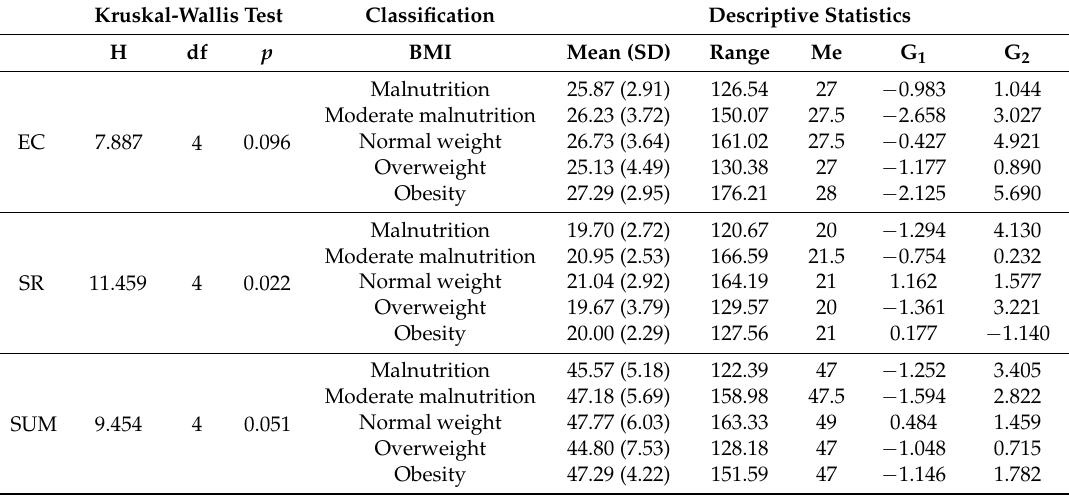
Table 7. Kruskal-Wallis test and descriptive statistics for social-emotional skills according to BMI for the sample of girls.